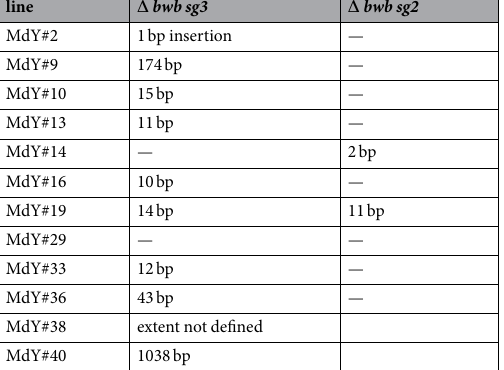
allele. In all crosses, all progeny displayed bwb phenotype. Lack of melanization in these animals is consistent with our hypothesis that MdY is required for proper pigmentation of the cuticle. Furthermore, non-complementation of the Cas9-induced MdY alleles with all mutant bwb alleles of the aabys and M III strains confirms our initial hypothesis that bwb corresponds to the yellow ortholog of Musca domestica . Line MdY#29 was of particular interest, as we did not detect any sequence modifications at the two target sites in exon 2 (Table 2). Nonetheless, this line produced both brown M III pw + males and also pw females with normal melanization. The reciprocity of these sex-specific phenotypes suggests Cas9-mediated double-strand breaks in MdY induced an intragenic recombination event between the bwb + allele on the M III chromosome and males in line MdY#29 that are unaffected at the two Cas9 target sites, but homozygous for the MdY b signature